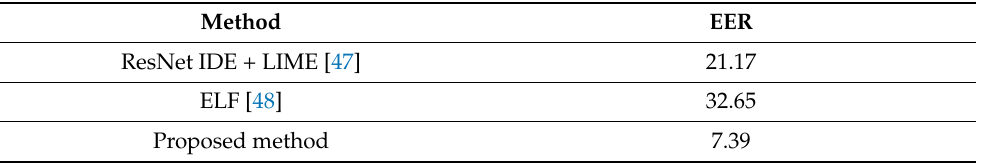
Table 18. Comparison of EERs using the proposed method and state-of-the-art body and face recognition methods (unit: